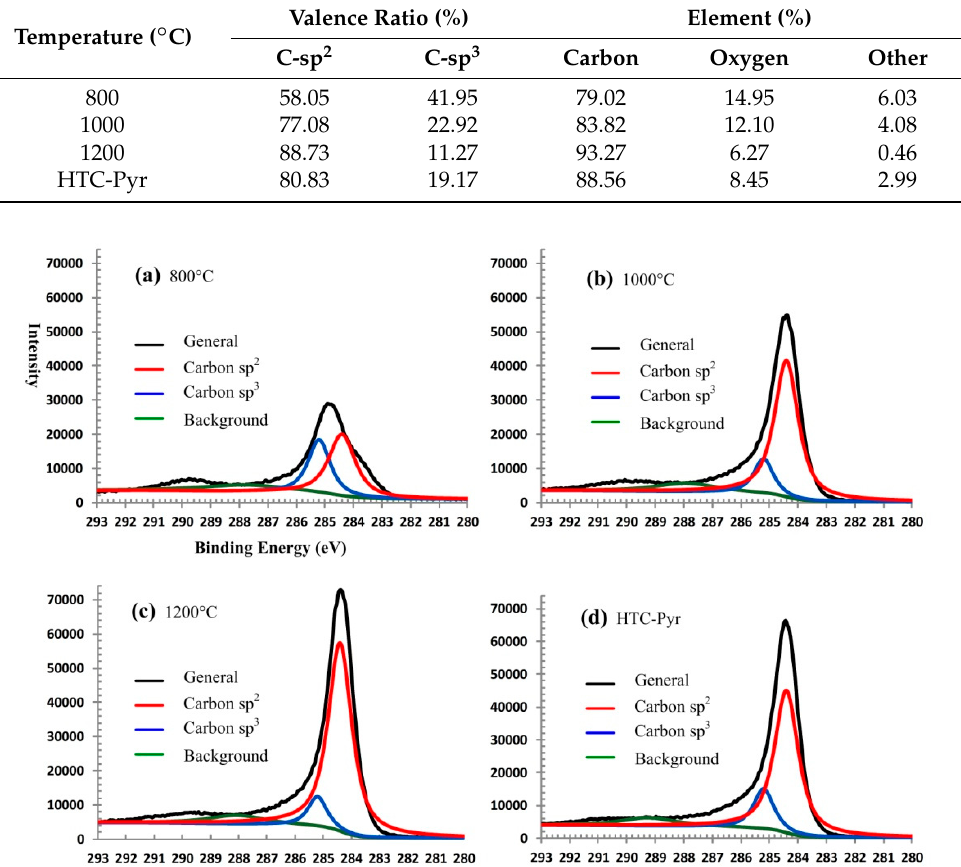
Figure 11. The XPS spectra of GMC samples prepared at three temperatures and using an